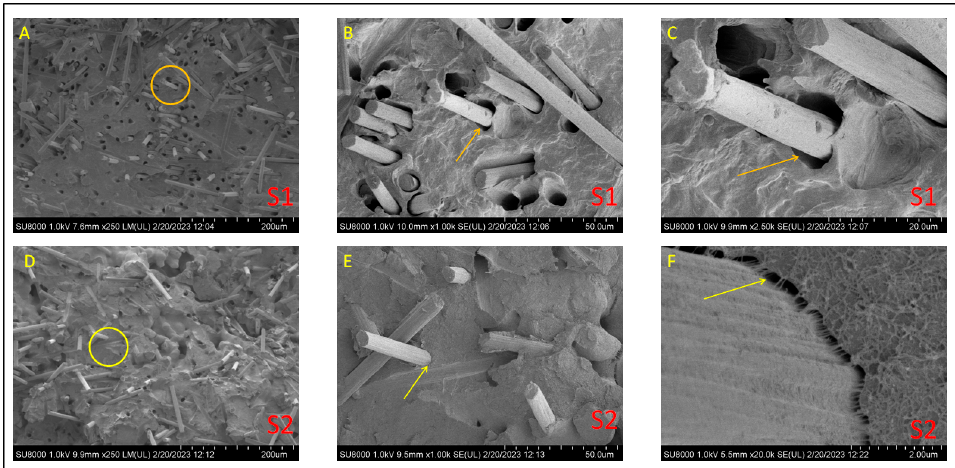
Figure 5. FESEM images taken from S1 ( A – C ) and S2 ( D – F ) compressed samples observed at different magnification levels .